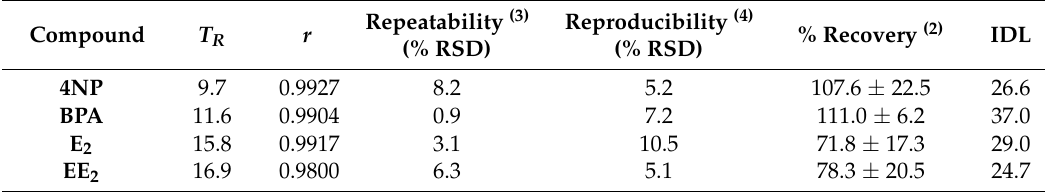
Table 2. Results for evaluation of analytical method.